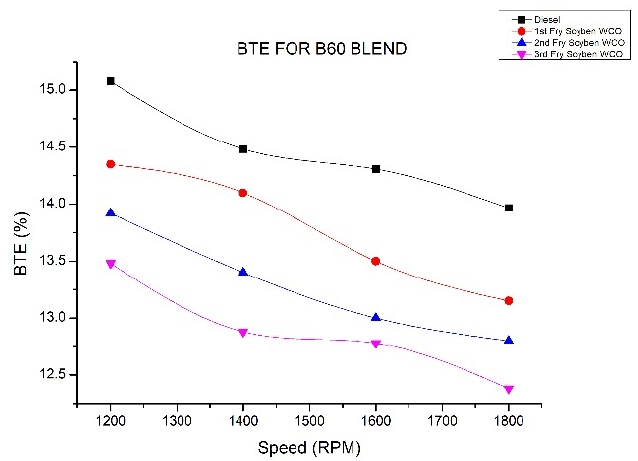
Figure 4. BTE of different fry oils (B60 blend) at different rpm.